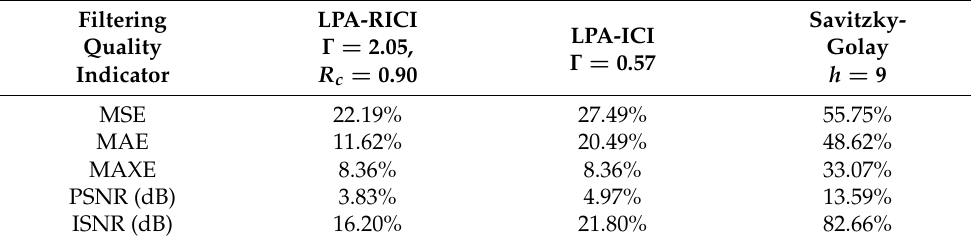
Table 11. Bumps signal (SNR = 5 dB)—Filtering quality improvement of the RBF-RICI-based filtering over other tested algorithms.